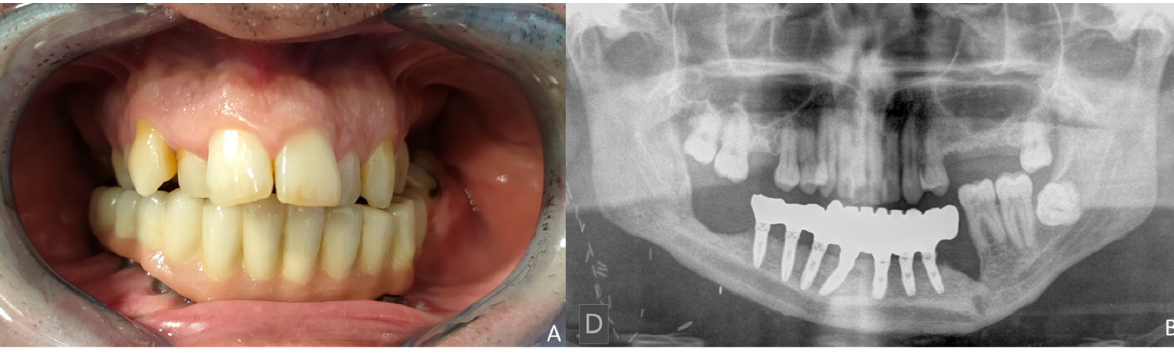
Figure 12. Final aesthetic result. ( A ) Aesthetic result with mandibular symmetry. ( B ) Aesthetic profile with a good projec- tion of the lower facial third. CT Scan and CBCT were performed in the postoperative follow-up, and bone volume and bone resorption (Figures 13 and 14) were evaluated by the Radiology Department of the hospital. A morphing reconstruction was performed to compare the lower facial third showing an improvement in the aesthetic profile and facial projection (Figure 15).